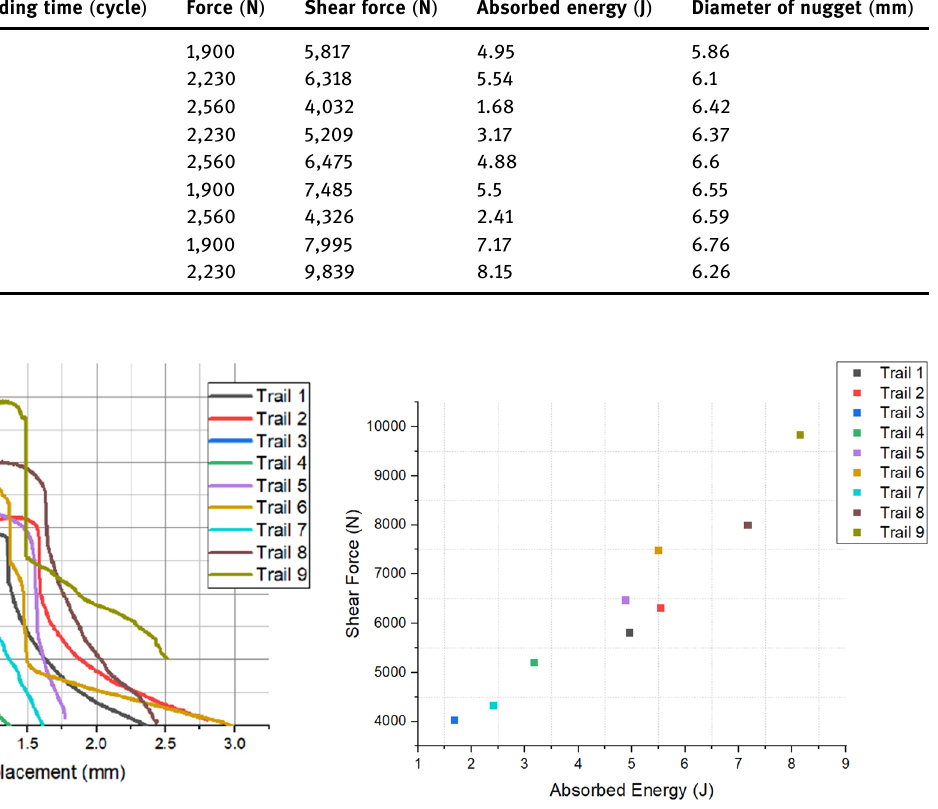
Table 4: The result of Tensile shear test Trial